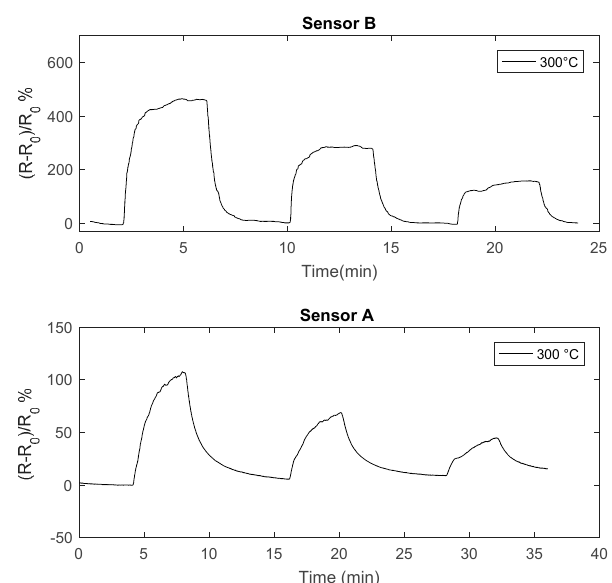
Figure 12. Resistance of the chemical film as a function of time when pulses (4 min length) with different concentration of NO 2 are injected into the measurement chamber (24 ppm,12 ppm, 6 ppm). The total flow is 200 mL/min, carrier gas is N 2 . The NO 2 concentrations are shown in the figure.